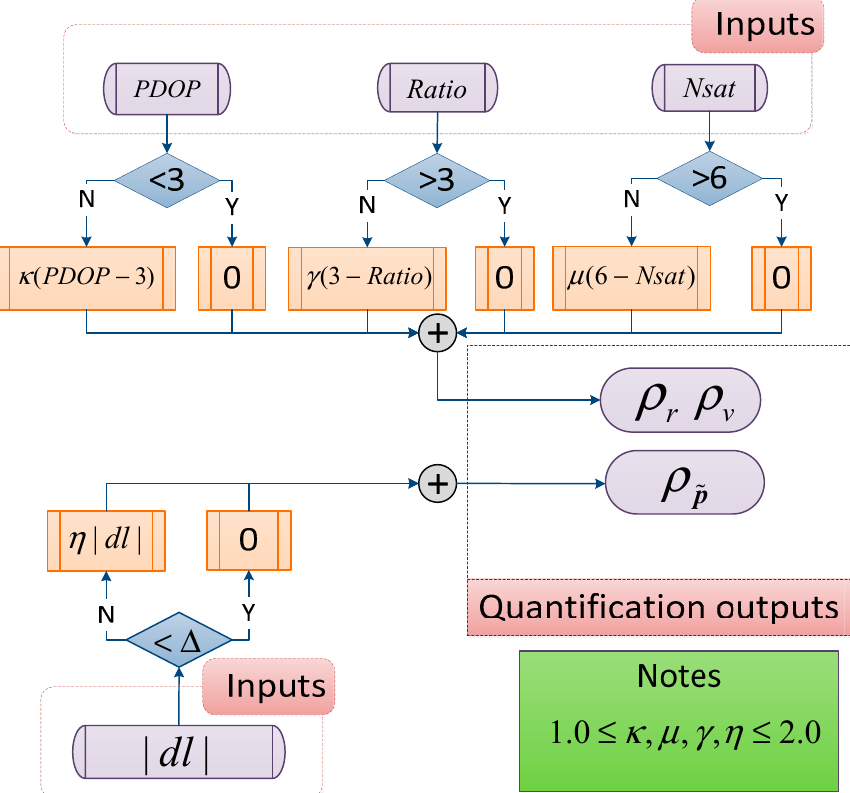
Figure 2. A quantification algorithm of Global Positioning System (GPS)-RTK reliability used in Equation (28) based on PDOP, number of valuable satellites, ratio, and length bias.